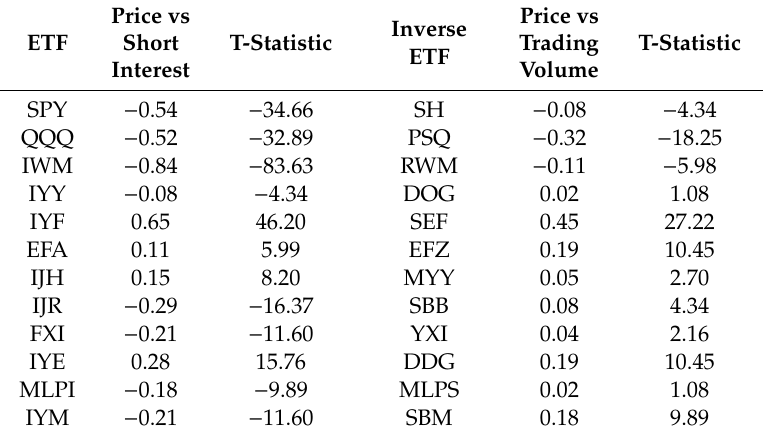
Table 2. Correlation coe ffi cients between ETF price and their short interest, and between inverse ETF price and their trading volume (observation period 2011–2017). Price vs Price vs Inverse Trading ETF Short T-Statistic ETF Volume Interest